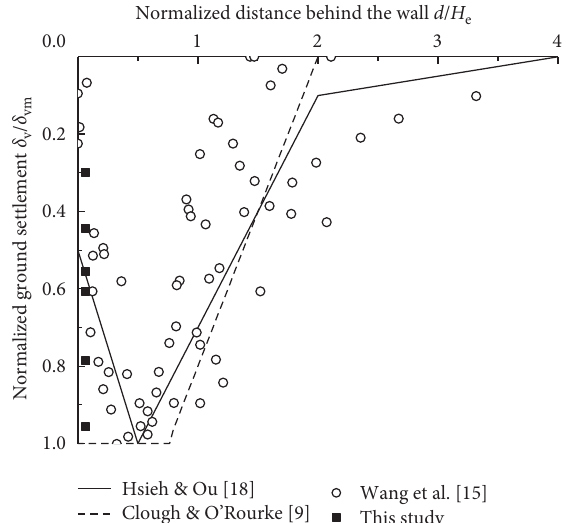
Figure 18: Normalized ground surface settlement perpendicular to the excavation area.